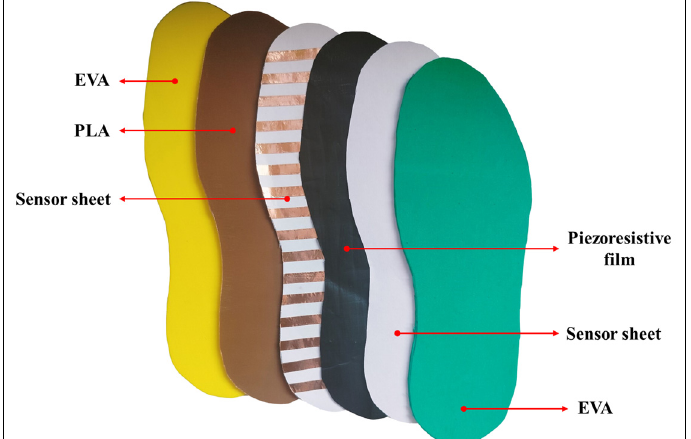
Figure 6. Materials used in the development of the pressure insole.